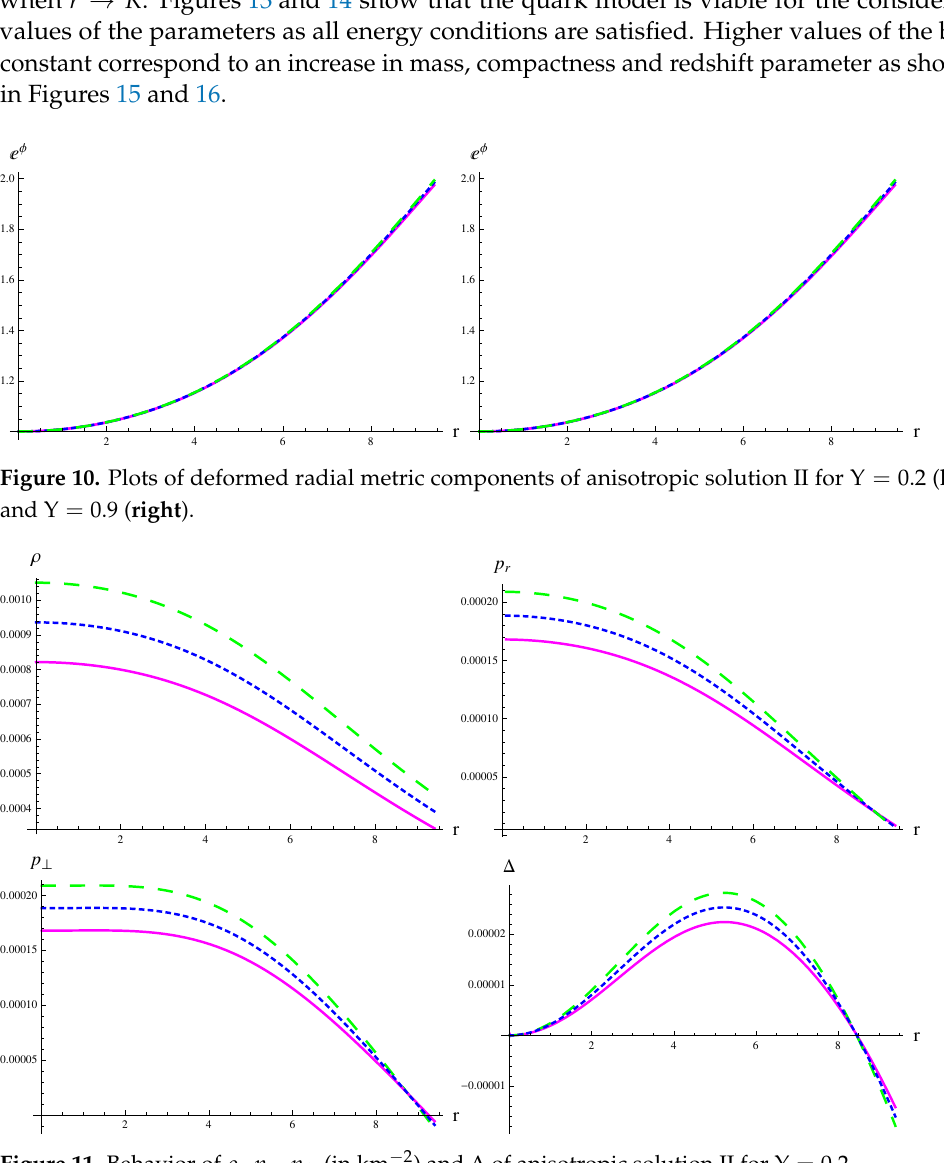
Figure 11. Behavior of ρ , p r , p ⊥ (in km − 2 ) and ∆ of anisotropic solution II for Υ =